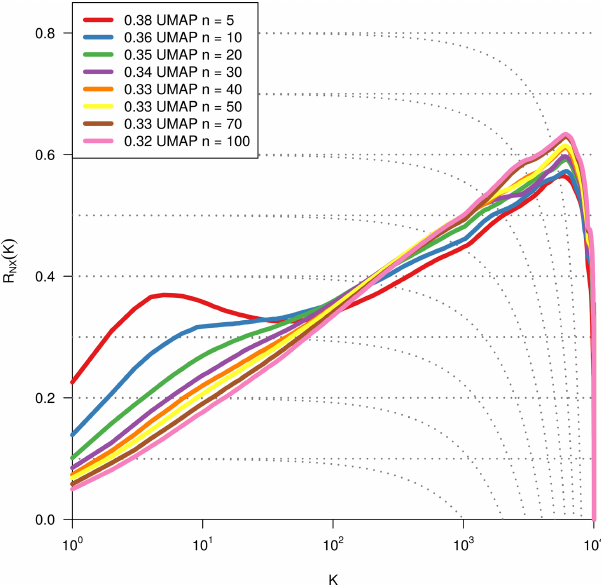
Figure B3. Same metric as Fig. B1. Optimisation of the dimensionality reduction to two dimensions via UMAP by using different values for the parameter n neighbours .